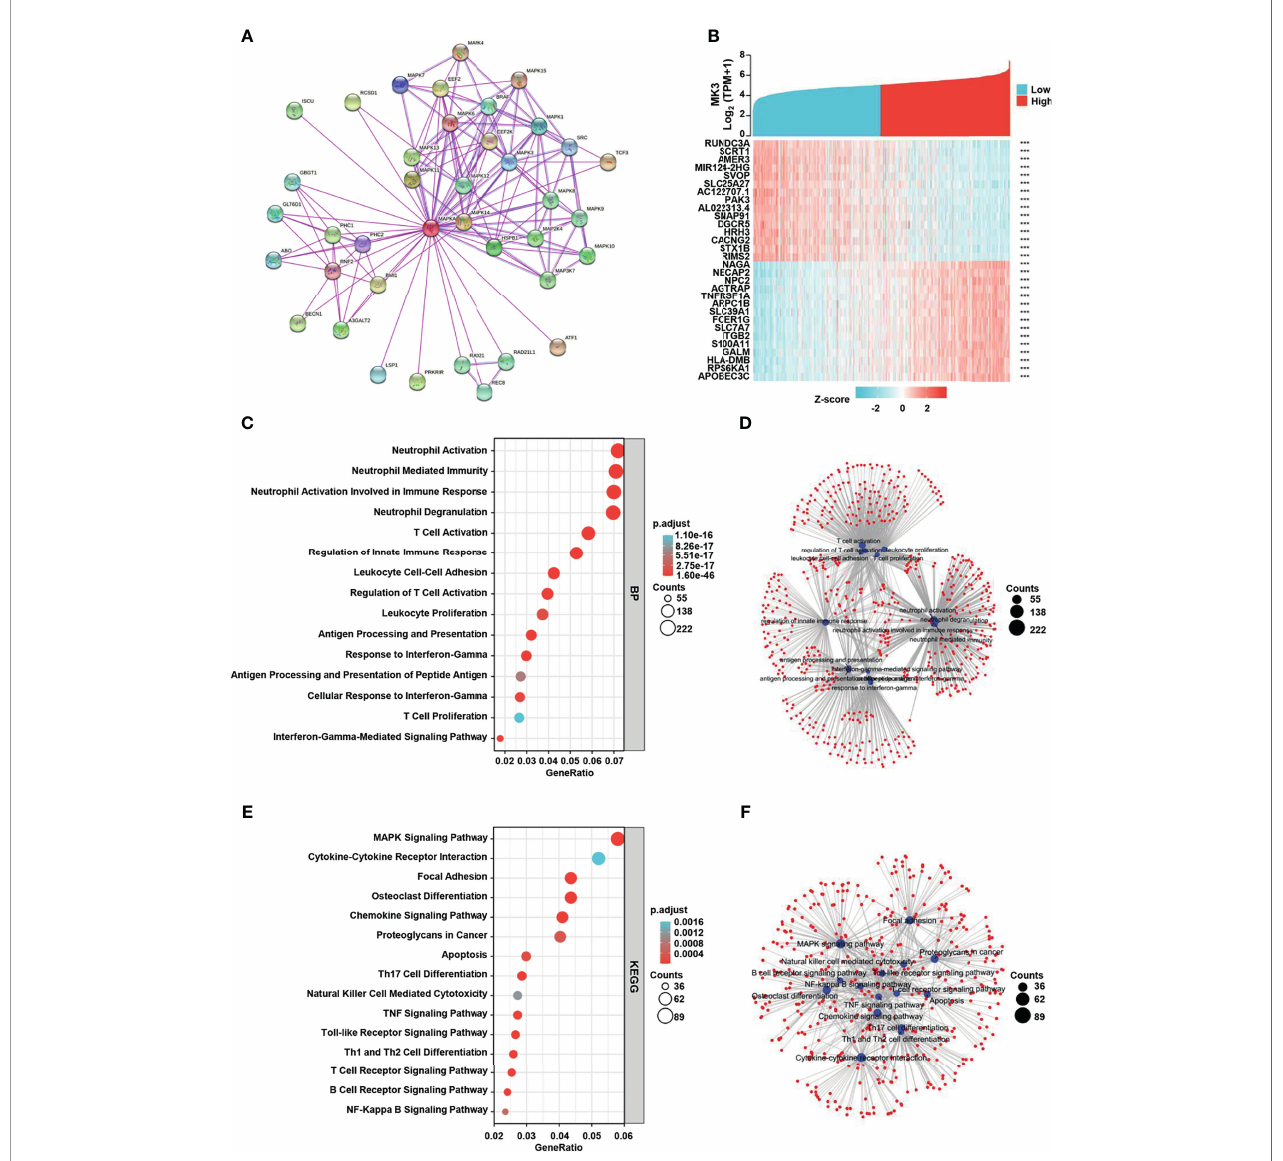
FIGURE 4 | MK3 related gene enrichment analysis. (A) The protein – protein interaction network analysis of MK3 by using the STRING tool. (B) The top 15 genes with positive and negative correlations of MK3 expression. (C) Based on the MK3 related genes, GO analysis was performed. (D) The cnetplot of biological process in GO analysis. (E) KEGG pathway analysis of MK3 related genes. (F) The cnetplot of KEGG pathway analysis. Data used for GO and KEGG analyses were obtained from TCGA. GO, Gene Ontology; KEGG, Kyoto Encyclopedia of Genes and Genome; TCGA, The Cancer Genome